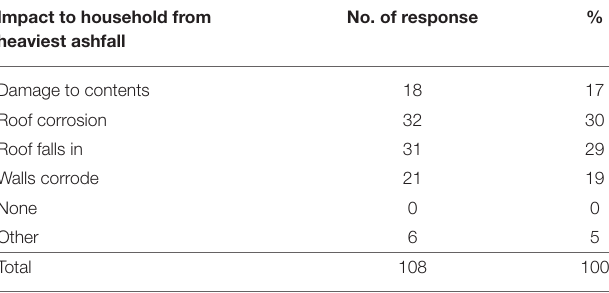
TABLE 5 | Questionnaire interview results in ashfall impacts on